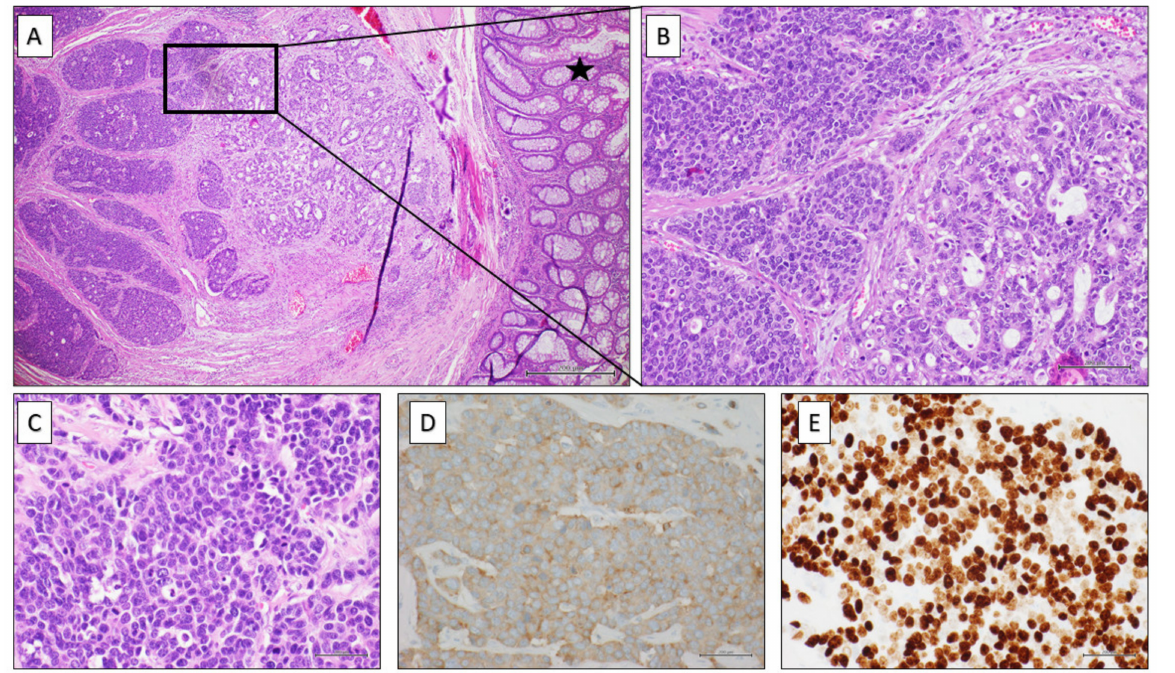
Figure 2. ( A ) Colonic segment partially covered by normal mucosa (black star) showing infiltra- tion, on the left side of the image, by a carcinoma with a double component: neuroendocrine and adenocarcinomatous one (H&E 4 × magnification). ( B ) A detail of image ( A ) showing at higher magnification the neuroendocrine population (on the left side) arranged in pseudo-rosettes or tra- beculae, composed of medium-sized cells with irregular nuclei and granular chromatin and the adenocarcinomatous component (on the right side) with evident glandular structures made up of atypical cylindrical cells (H&E 20 × magnification). ( C ) High mitotic index typical of neuroendocrine carcinomas (H&E 40 × magnification). ( D ) Strong positivity for synaptophysin at immunohisto- chemistry (40 × magnification). ( E ) High proliferative index (Ki67) at immunohistochemical assay (40 ×